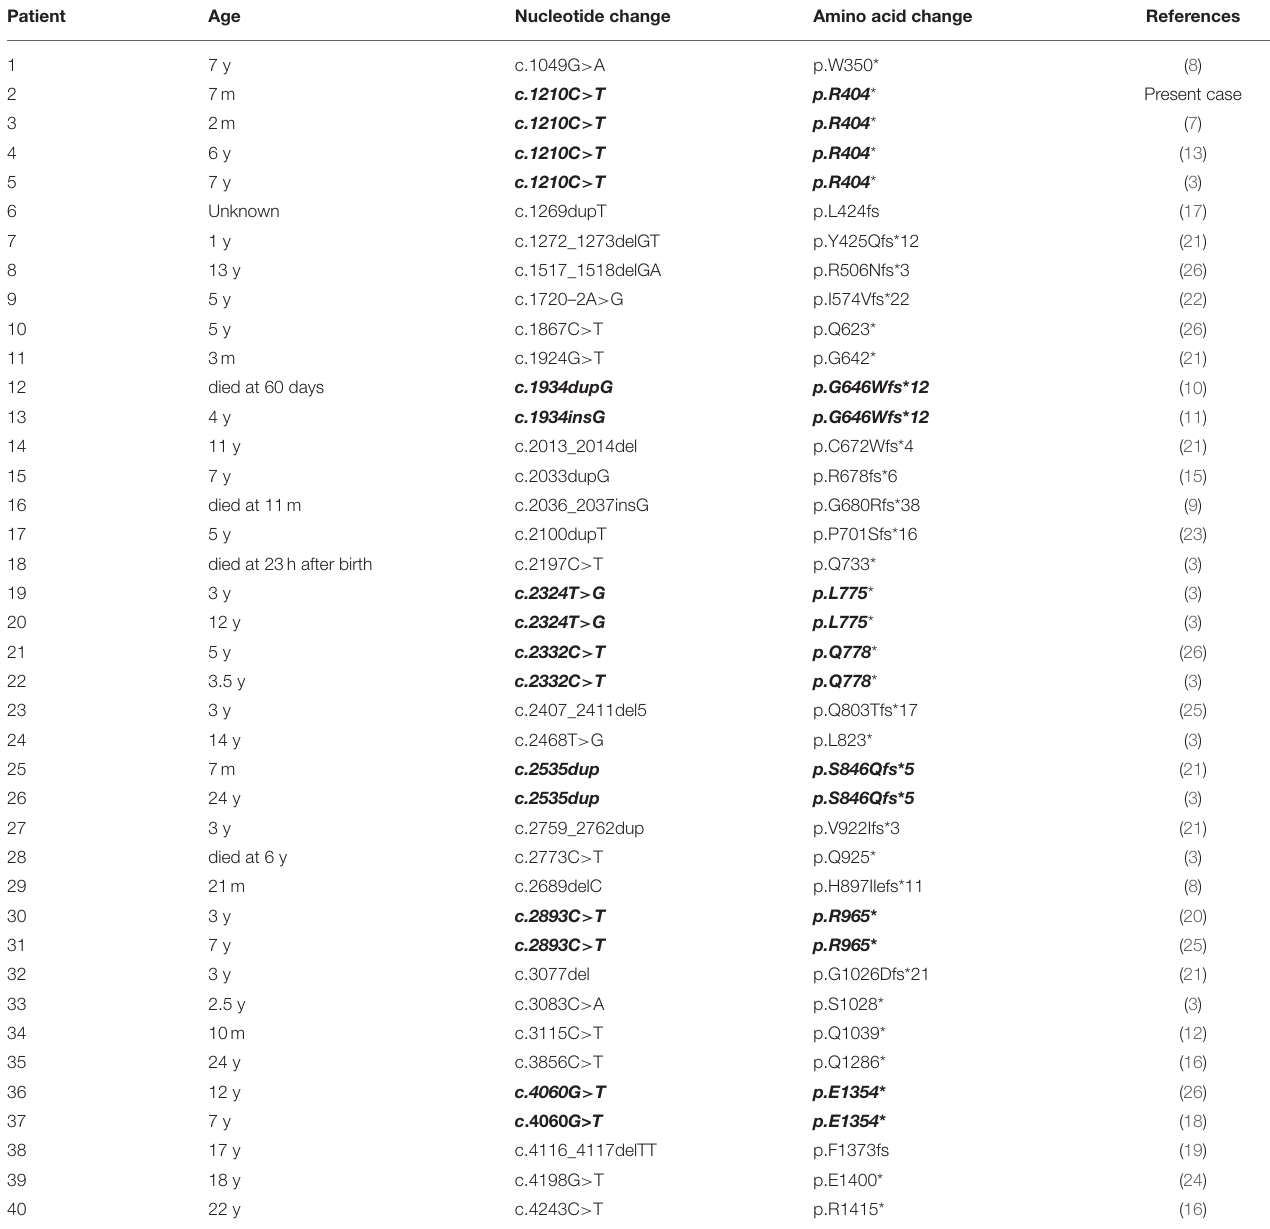
TABLE 2 | Previously reported BOS cases and the present case carrying ASXL1